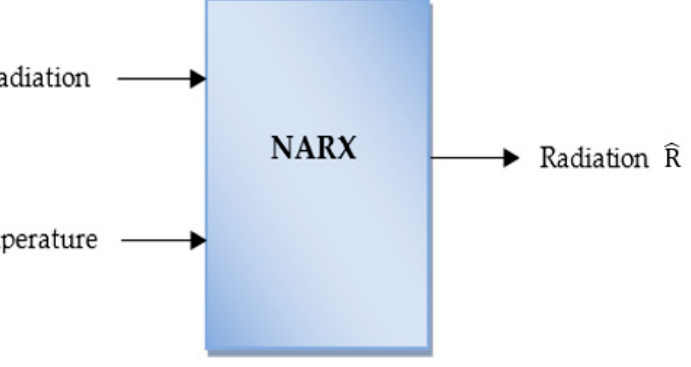
Figure 27. Inputs and output of the NARX model.